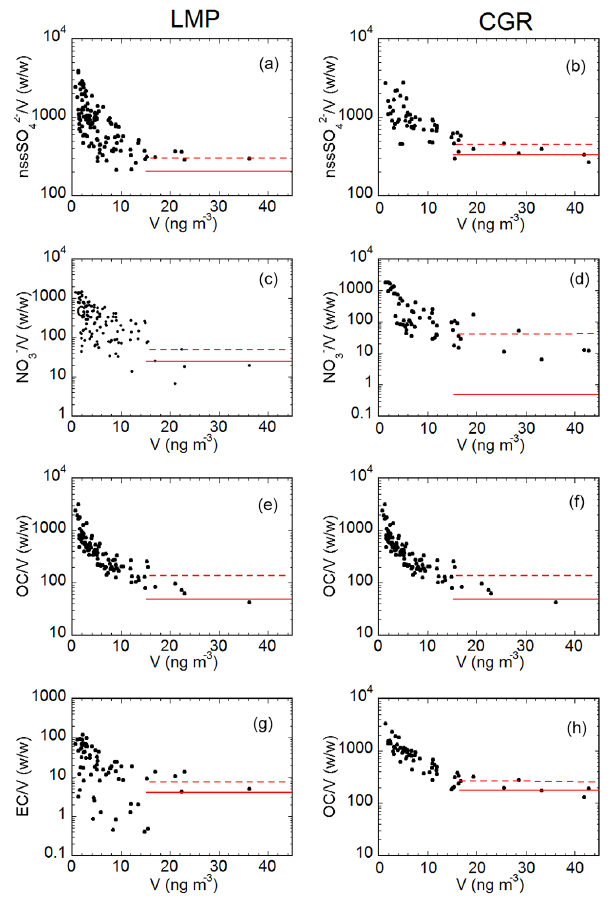
/ V (a, b) , NO − / V (c, d) , Figure 8. Scatter plots of nssSO 2 − 4 3 OC / V (e, f) and EC / V (g, h) vs. V concentration at LMP (plots on the left) and CGR (plots on the right). The red lines in the plots rep- resent the average (dashed line) and the average minus one standard deviation (solid line) calculated for samples with V > 15ngm − 3